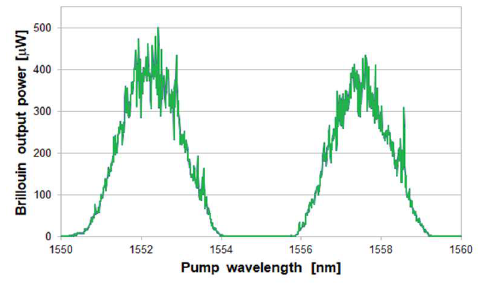
Fig. 2. Double resonance peaks for a cavity length of 5 m